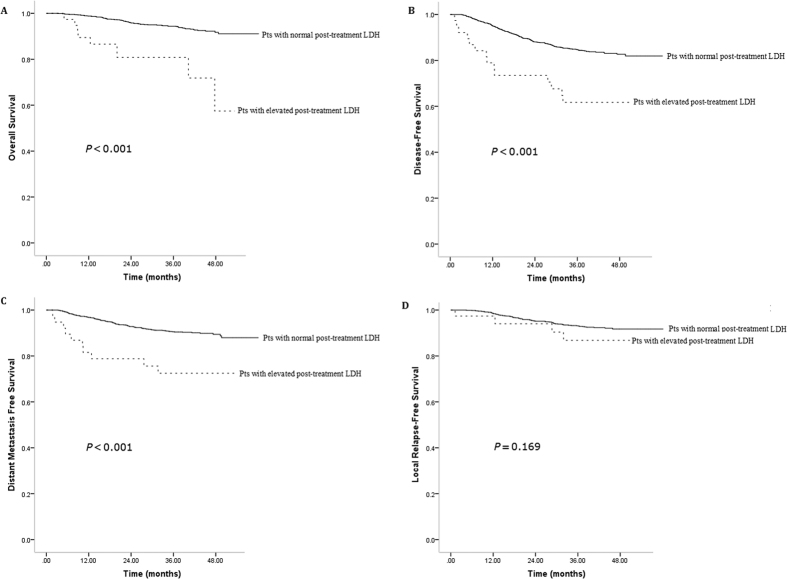
Kaplan–Meier survival curves showing overall survival rates (A), disease-free survival rates (B), distant metastasis–free survival rates (C) and local relapse–free survival rates (D) in nasopharyngeal carcinoma patients with elevated or normal post-treatment levels of lactate dehydrogenase (LDH).